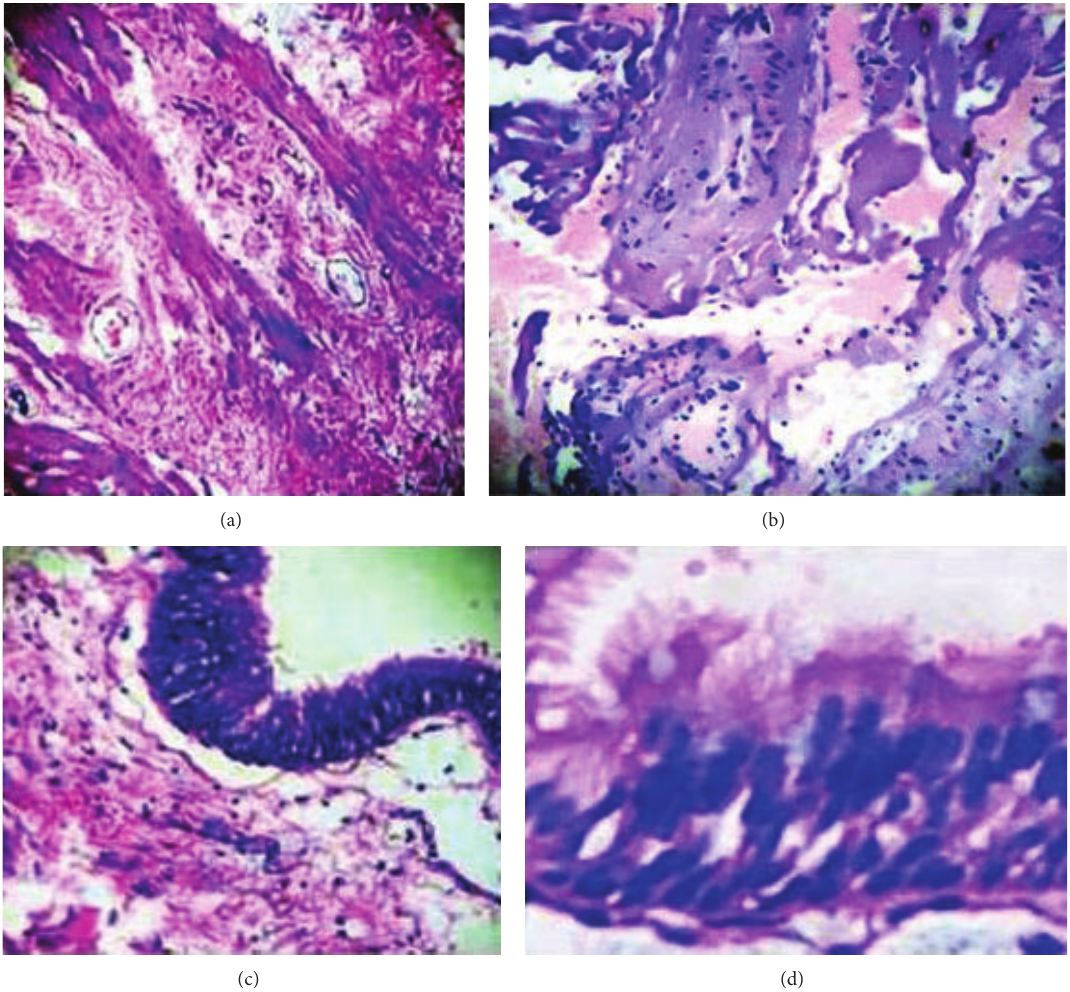
Figure 3: (a) and (b) are photomicrographs showing the cyst wall containing smooth muscle bundle fibres arranged in two layers: circular and longitudinal. (c) and (d) reveal the lining epithelium to be pseudostratified ciliated columnar (H&E;